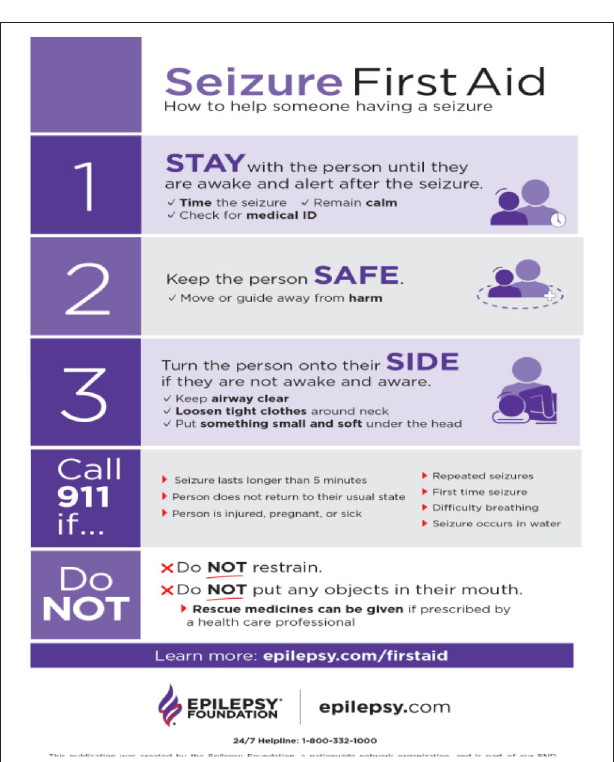
FIGURE 1 | Epilepsy Foundation (2020) campaign best practices flier.